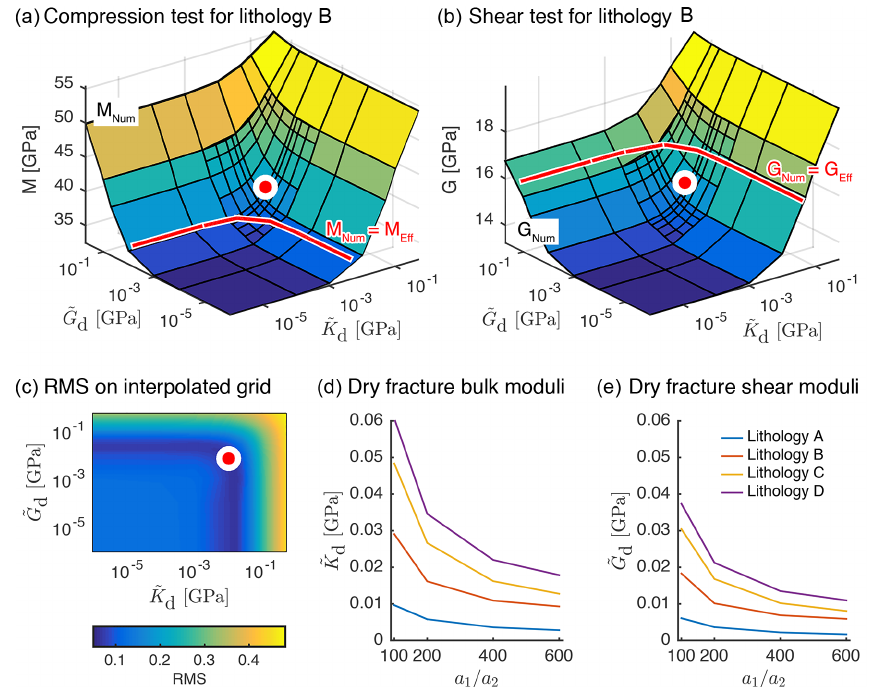
Figure 6. Comparison of the fractured rock P-wave modulus (a) and shear wave modulus (b) resulting from numerical modeling for varying fracture elastic moduli (colored surface) with the solution resulting form the effective medium theory (red lines) shown by way of example for lithology B with fracture aspect ratios a 1 /a 2 = 400. (c) Resulting RMS deviations between the numerical modeling results and the effective medium solution with the minimum (under the assumption of e K d / e G d ≈ 1 . 5) indicated by the red dot. (d, e) e K d and e G d for all lithologies A, B, C, and D and for the dry frame bulk and shear moduli, respectively.